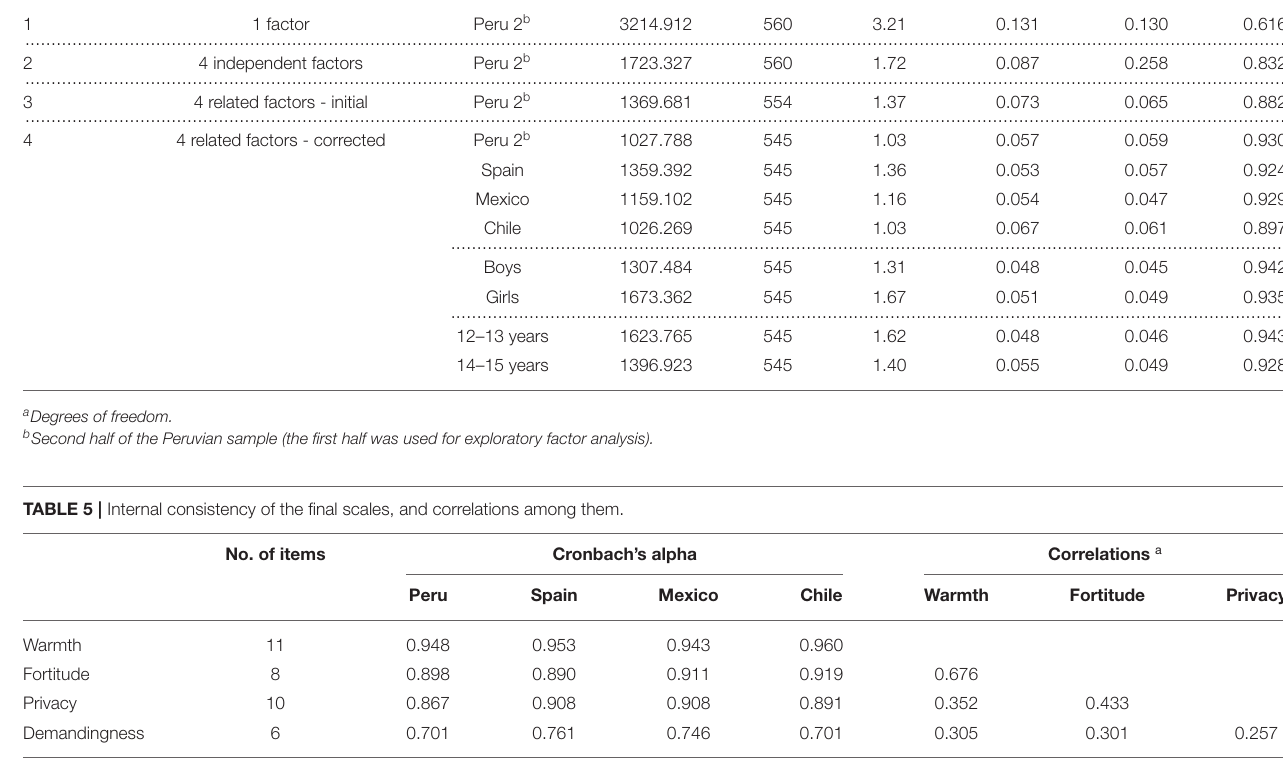
TABLE 4 | Fit indices in confirmatory factor analysis models. Model no.